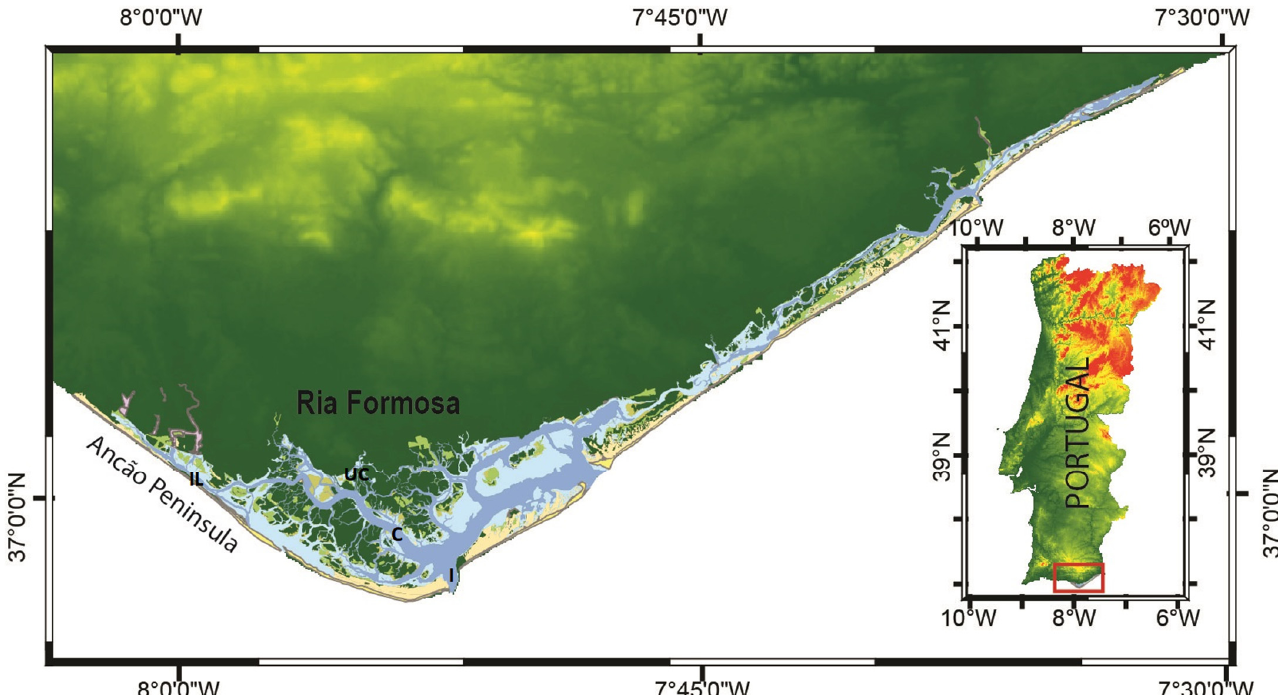
Figure 3. Map of the Ria Formosa coastal lagoon and sampling stations. IL—inner lagoon (landward boundary); UC—urban center (urban boundary); C—main navigational channel (intermediate lagoon domain); I—inlet (seaward boundary).